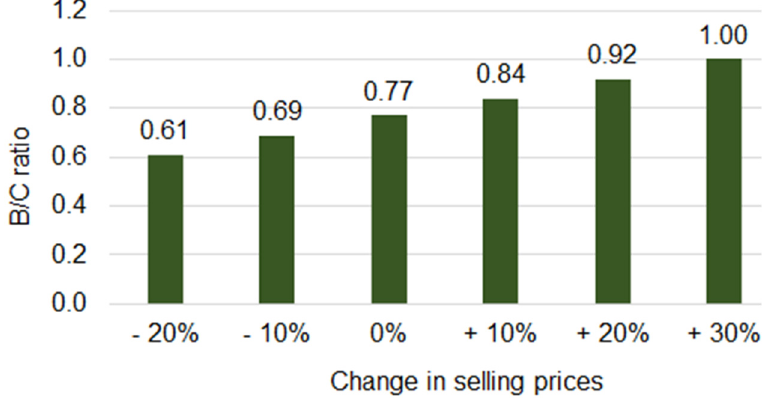
Figure 8. Effect of crop selling price changes to B/C ratio, case diesel.